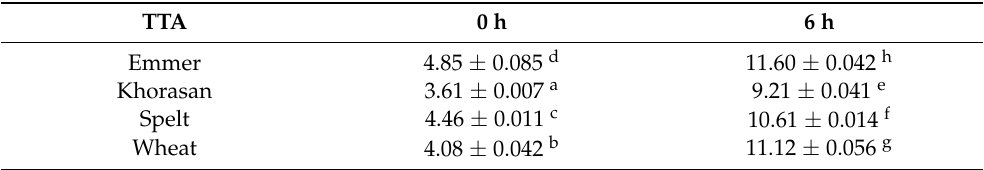
Table 2. Total titrable acidity (TTA) of sourdough samples from different wheat varieties before (0 h) and after (6 h) fermentation.